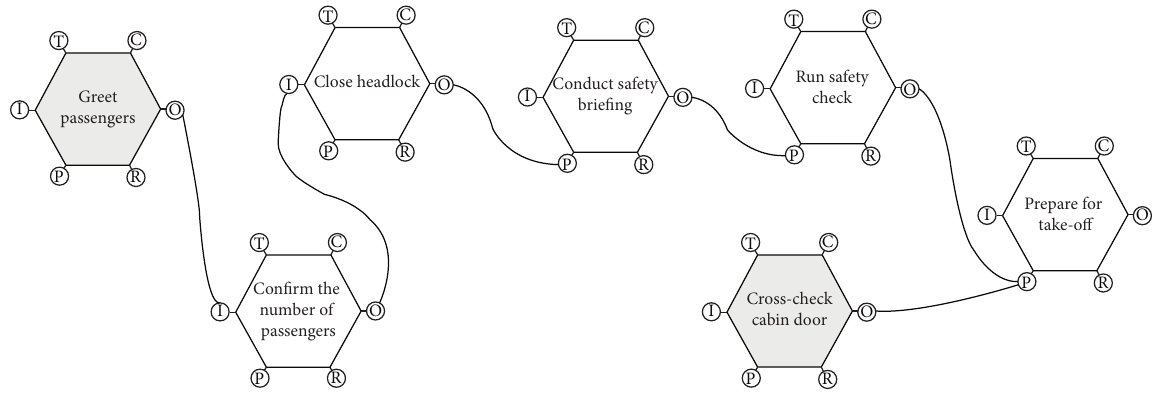
Figure 2: A simple FRAM net related to cabin crew’s work before take-off.